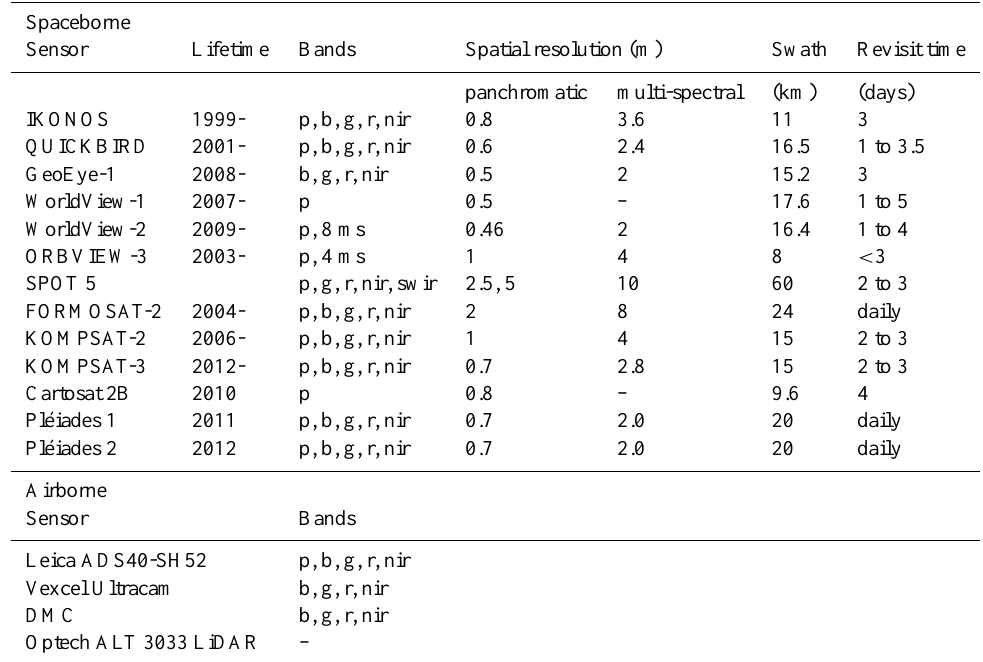
Table 1. Selection of VHR spaceborne and airborne sensors potentially suited for snow avalanche mapping. Note: for space-borne sensors, only commercial ones are listed. Spatial resolution is given at